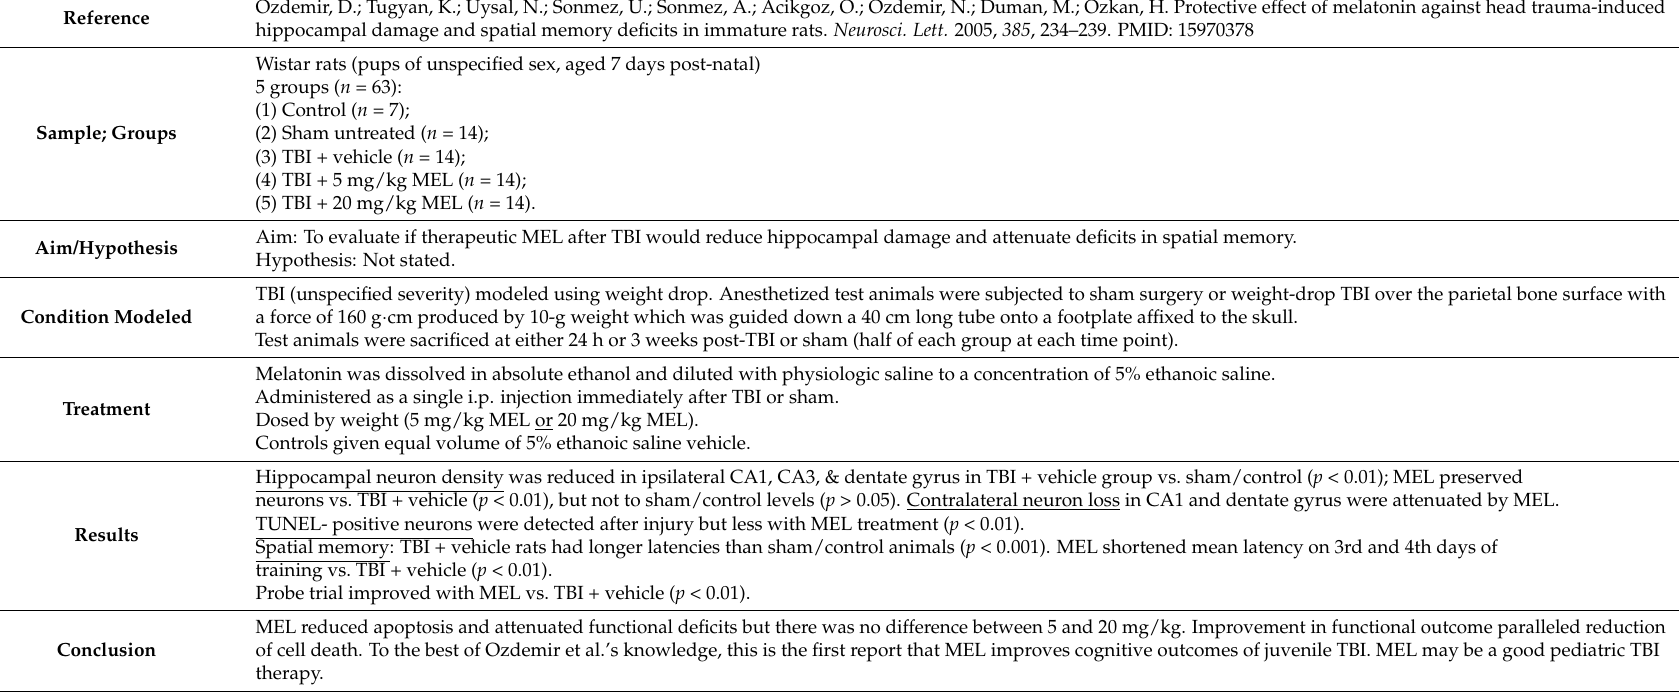
Table A6. Ozdemir et al. (2005) Study